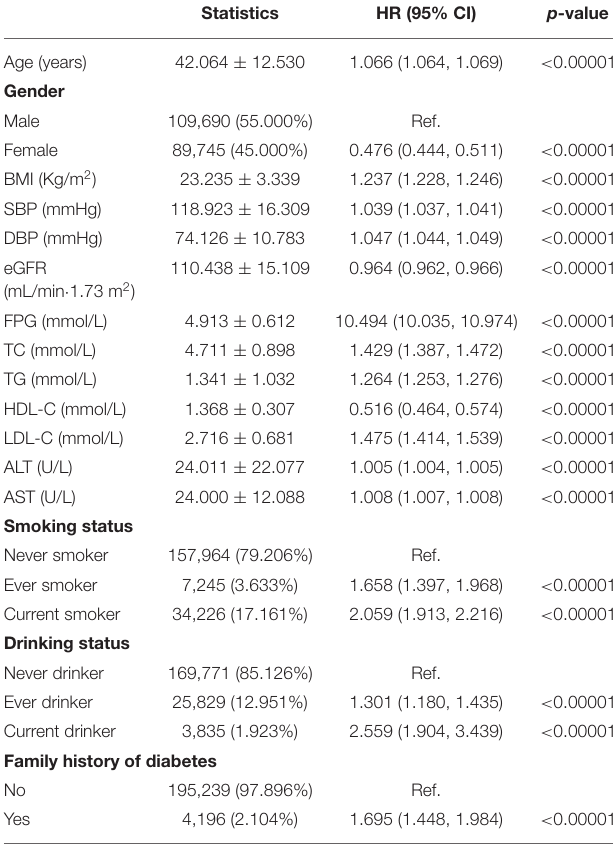
TABLE 3 | The results of univariate